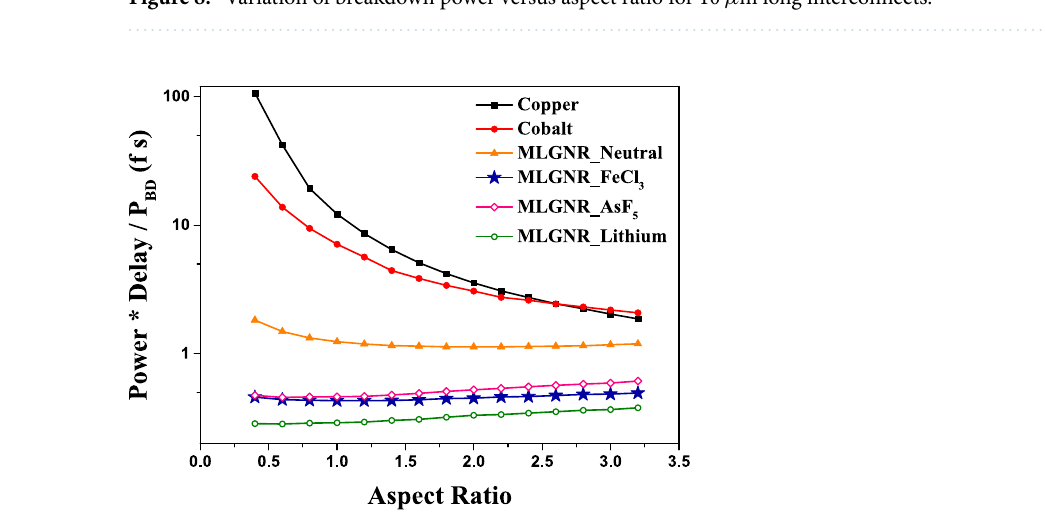
Figure 9. Optimized AR at minimum (power delay product/breakdown power) for 10 µ m long